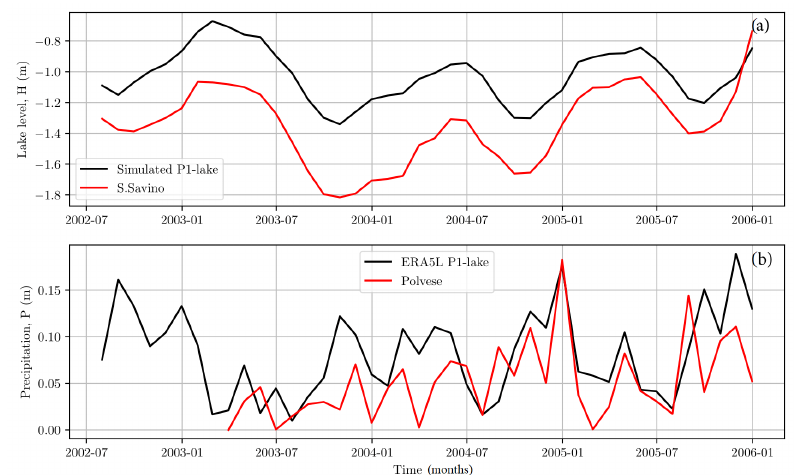
Figure 9. Comparison between ERA5L and ground-based observed data for the drought period 2002–2006: ( a ) monthly lake level, H , from ERA5L P1-Lake (in black) and the observed one at S. Savino station (in red); ( b ) precipitation over the lake (m/month), P , from ERA5L P1-Lake (in black) and the observed one at Polvese station (in red).